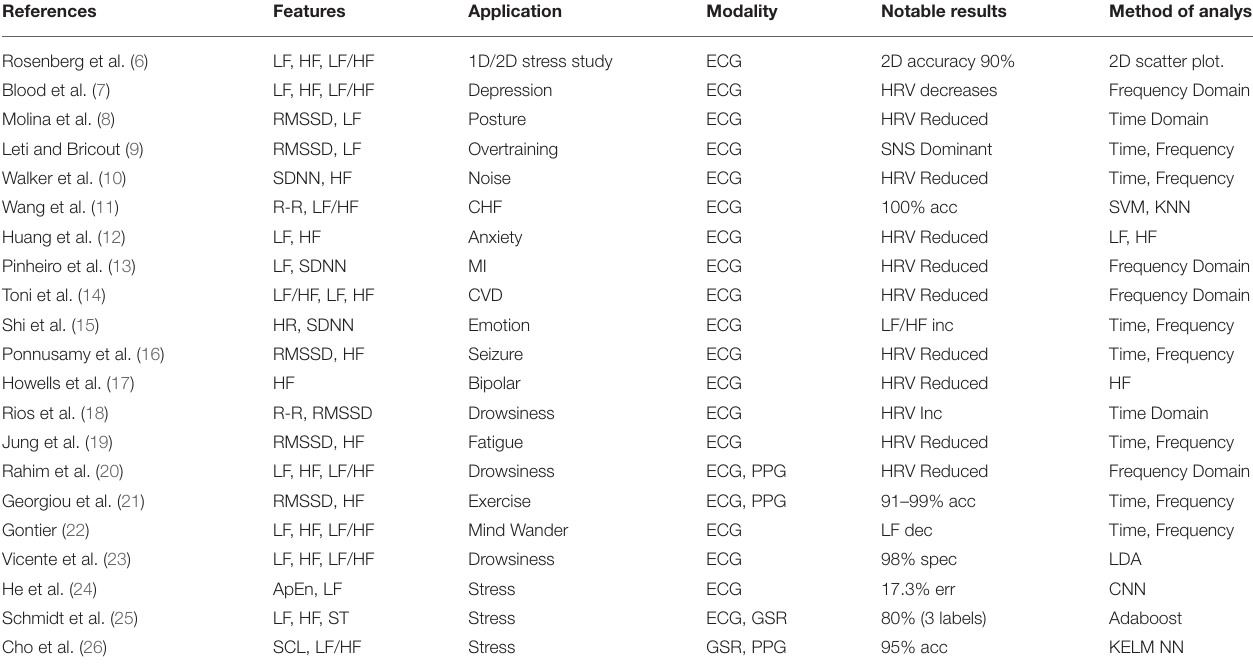
TABLE 1 | Research paper associated with HRV detected using an ECG, type of study, results of HRV, concepts being